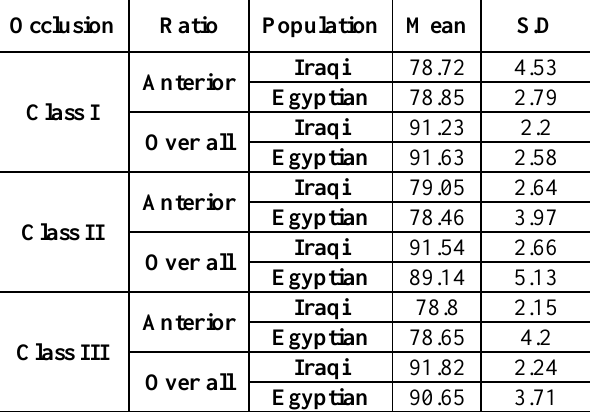
Table 1: Descriptive statistics for each ratio and